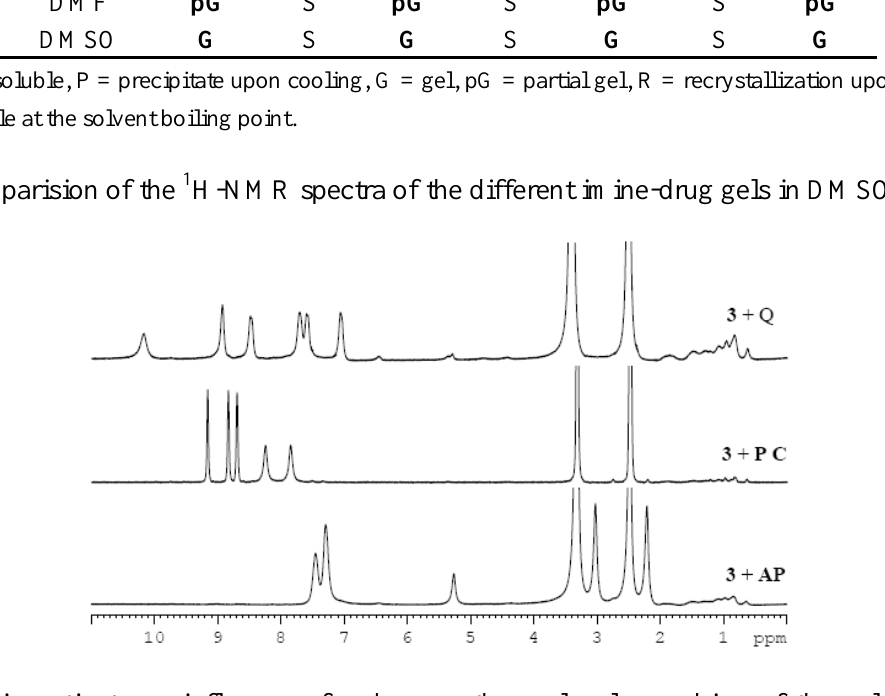
Figure 4. Comparision of the 1 H-NMR spectra of the different imine-drug gels in DMSO-d